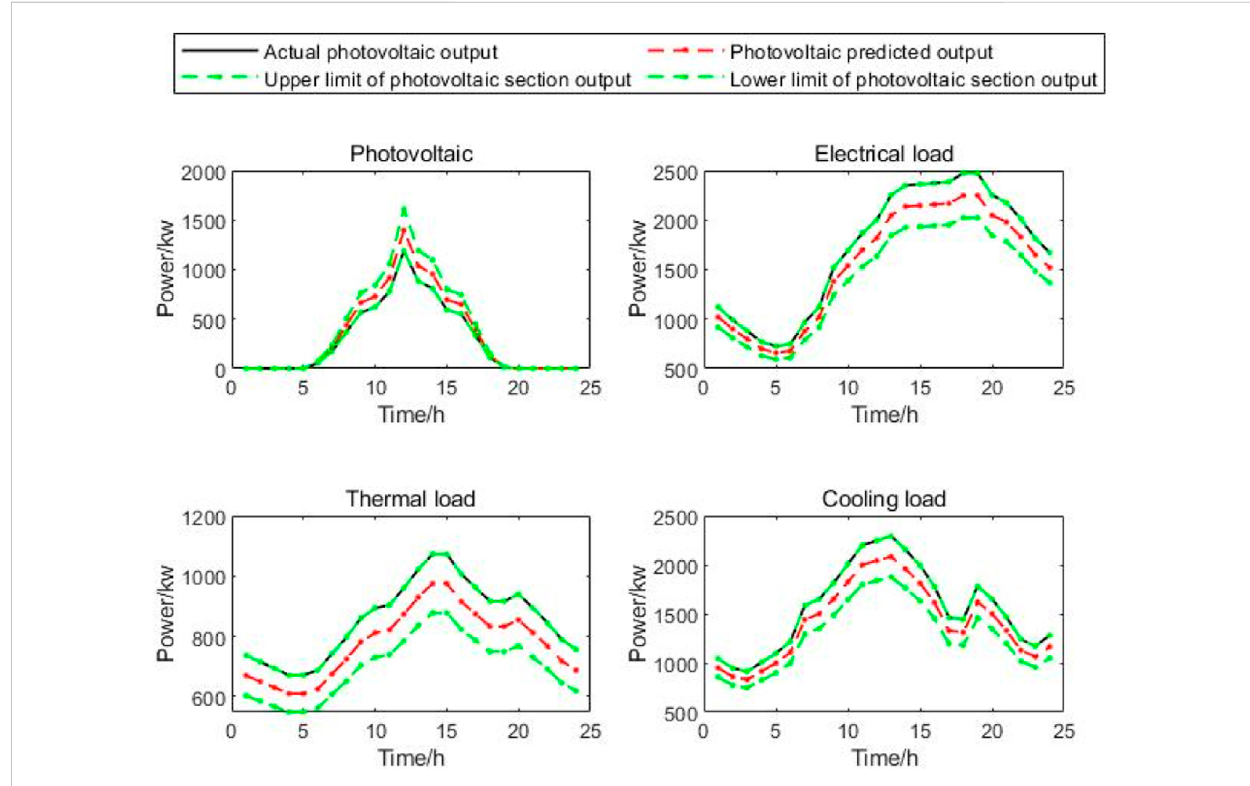
FIGURE 11 Uncertain parameters in the worst case for Γ (cid:1)